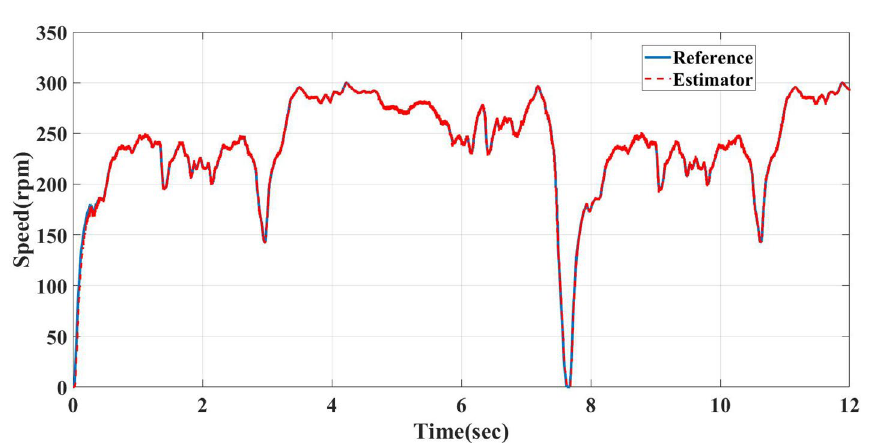
Figure 14. Reference HWFET speed cycle and straight-line guided by reference speed sensorless estimator of